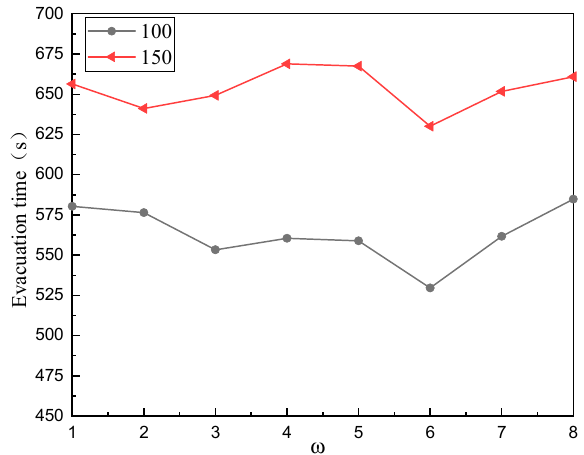
Figure 9. Effects of the expected heuristic factor β on evacuation time.